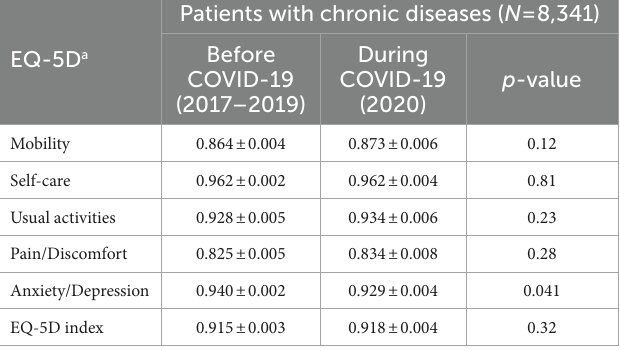
TABLE 3 Adjusted mean values of EQ-5D before and during the COVID-19 pandemic in patients with chronic diseases. Patients with chronic diseases ( N = EQ-5D a